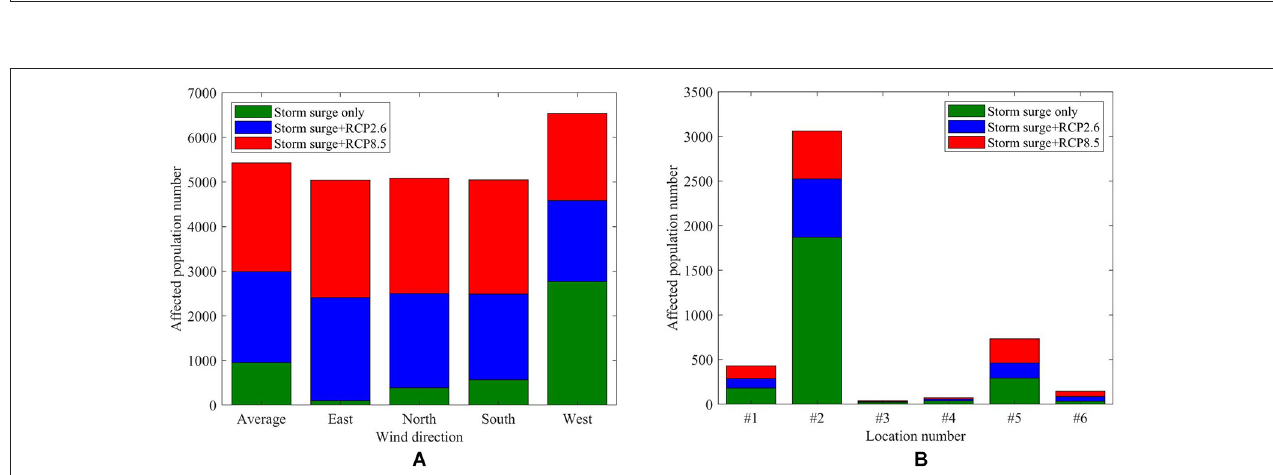
Frontiers in Climate |